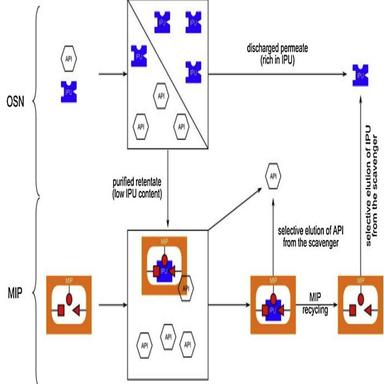
Schematic of the OSN-MIP system for the separation of API and IPU.